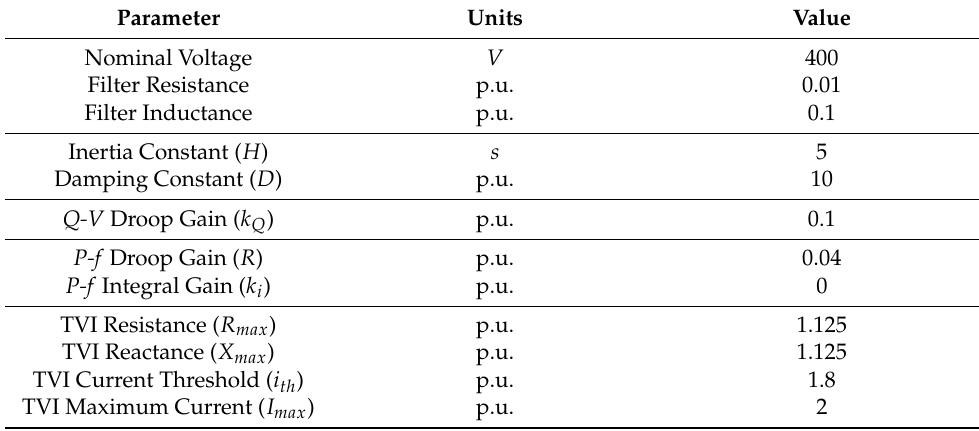
Table A2. Grid-forming default control